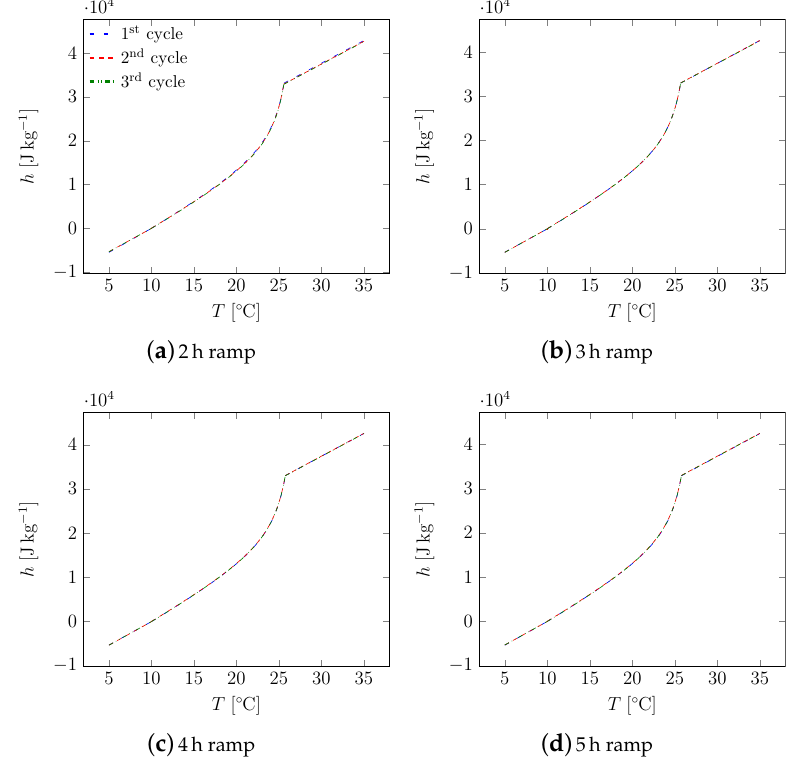
Figure A13. 19.2% w -PCM mortar: comparisons of the identified enthalpy functions with respect to the heating/cooling ramp ( n.b. unique formulation pertaining for both fusion and